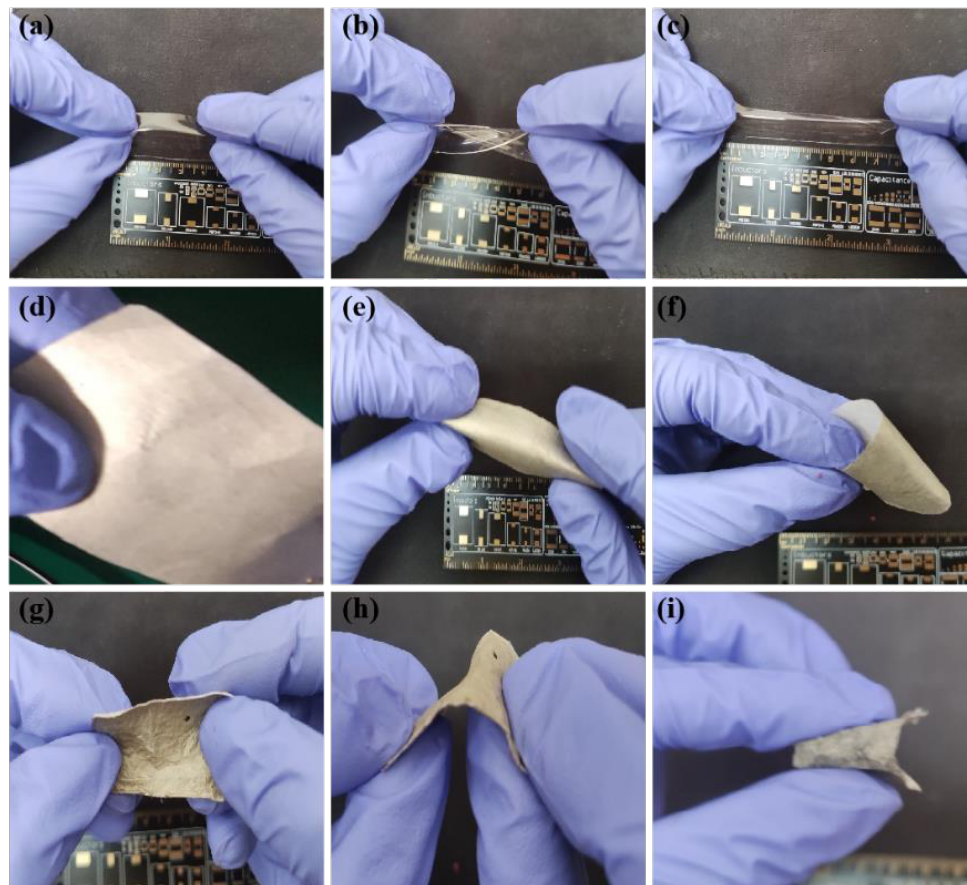
Figure 8. ( a – c ) Picture of PDMS − based flexible stretchable electrode under different deformations; ( d – f ) Picture of the paper − based flexible stretchable electrode under different deformations; ( g – i ) Picture of the nonwoven − based flexible stretchable electrode under different deformation.